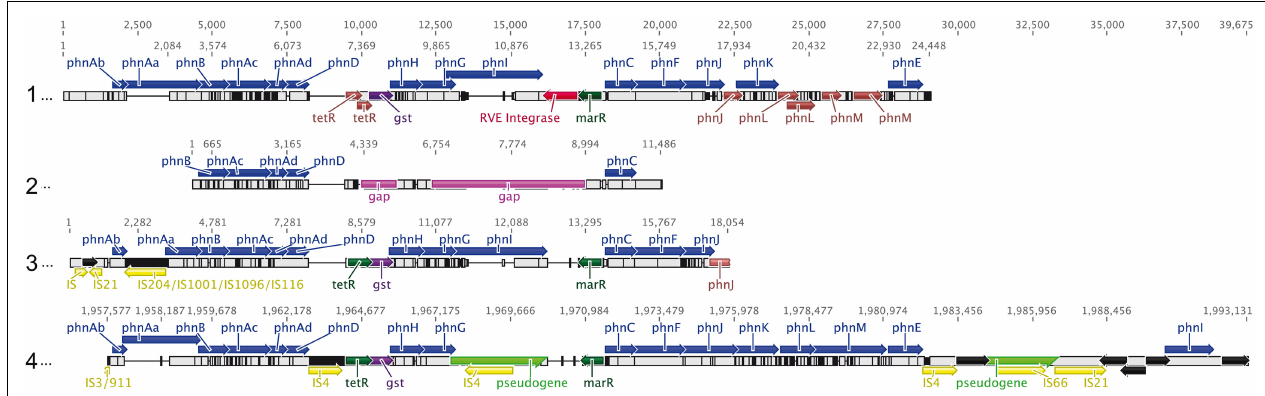
(yellow), regulatory elements (dark green), integrases (red), fragmented genes (brown), pseudogenes (bright green half arrows), and regions of sequence gaps (purple). Reactions catalyzed for all gene products except phnJ , phnK , phnL , and phnM (function unknown) are summarized in Figure 3 . For A. facaelis AFK2, features not annotated in the original GenBank entry included: phnJ , phnK , marR , the RVE-type integrase and all fragmented